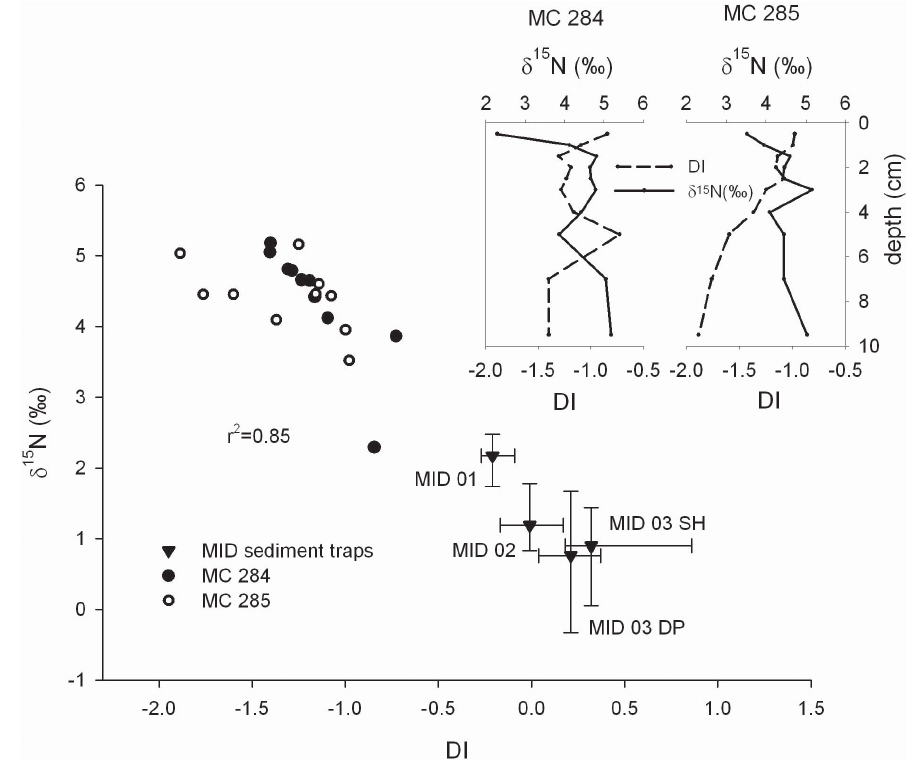
Fig. 2. δ 15 N vs. degradation index (DI) in cores MC 284/285 from Ierapetra Deep and mean values from MID sediment traps. Higher DI values indicate better preservation. Insert: high resolution records of δ 15 N and DI of multicores MC 284 and MC